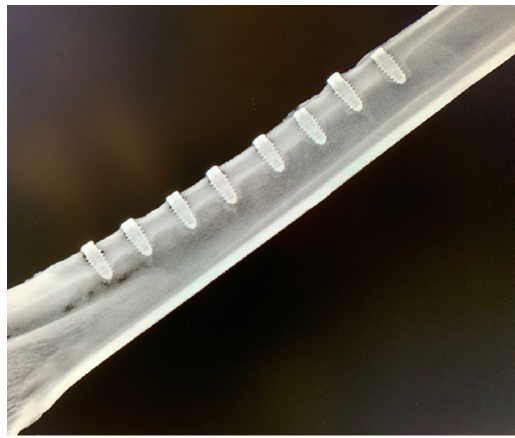
Figure 9. Radiographic view of the tibia and the inserted implants after 7-week healing.